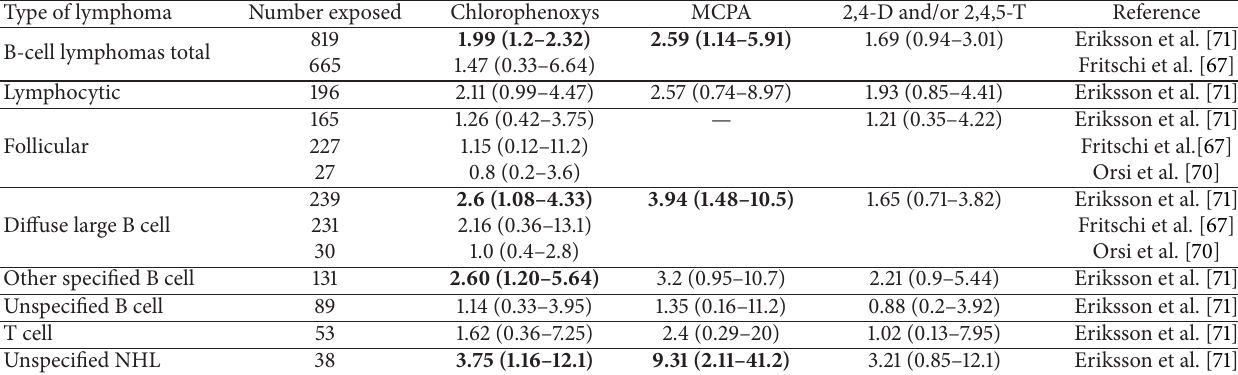
Table 4: Epidemiologic studies by histological subtype for